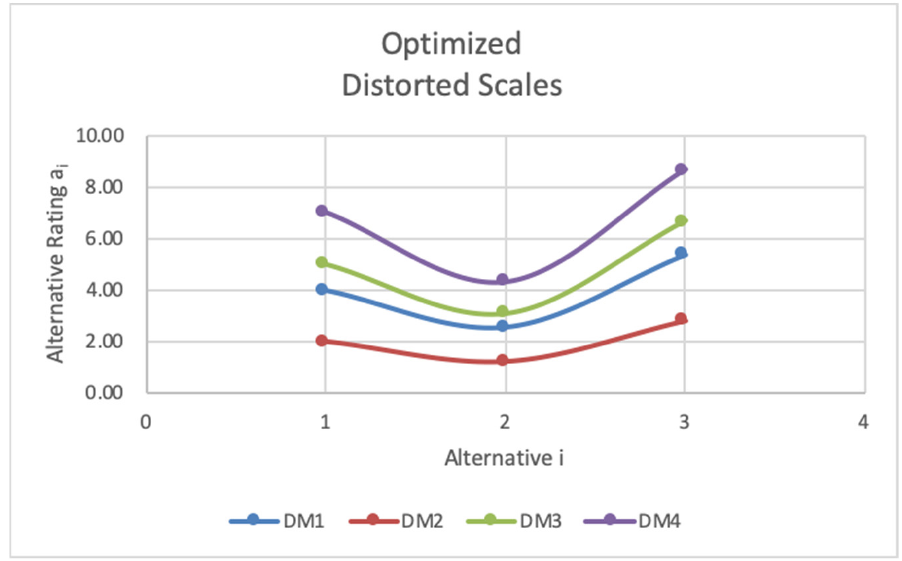
Figure 5. Balanced distorted scale scores between decision makers.